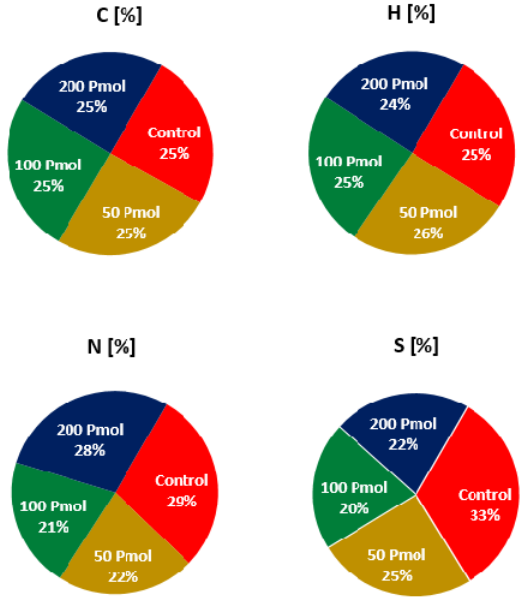
Figure 5. Variation in weight percentages of C, H, N, and S in spinach shoots after eight days of paracetamol treatment.